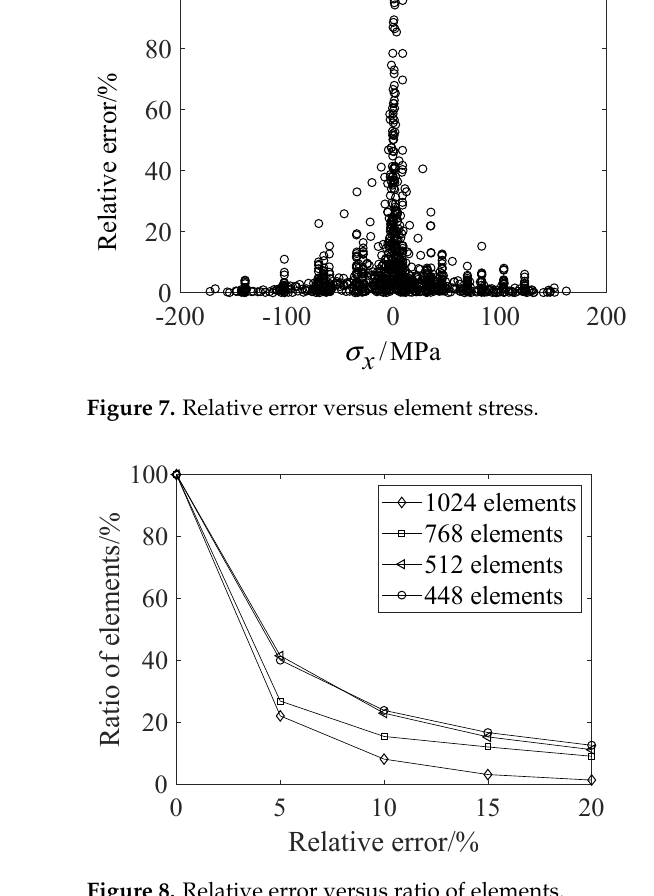
Figure 8. Relative error versus ratio of elements.